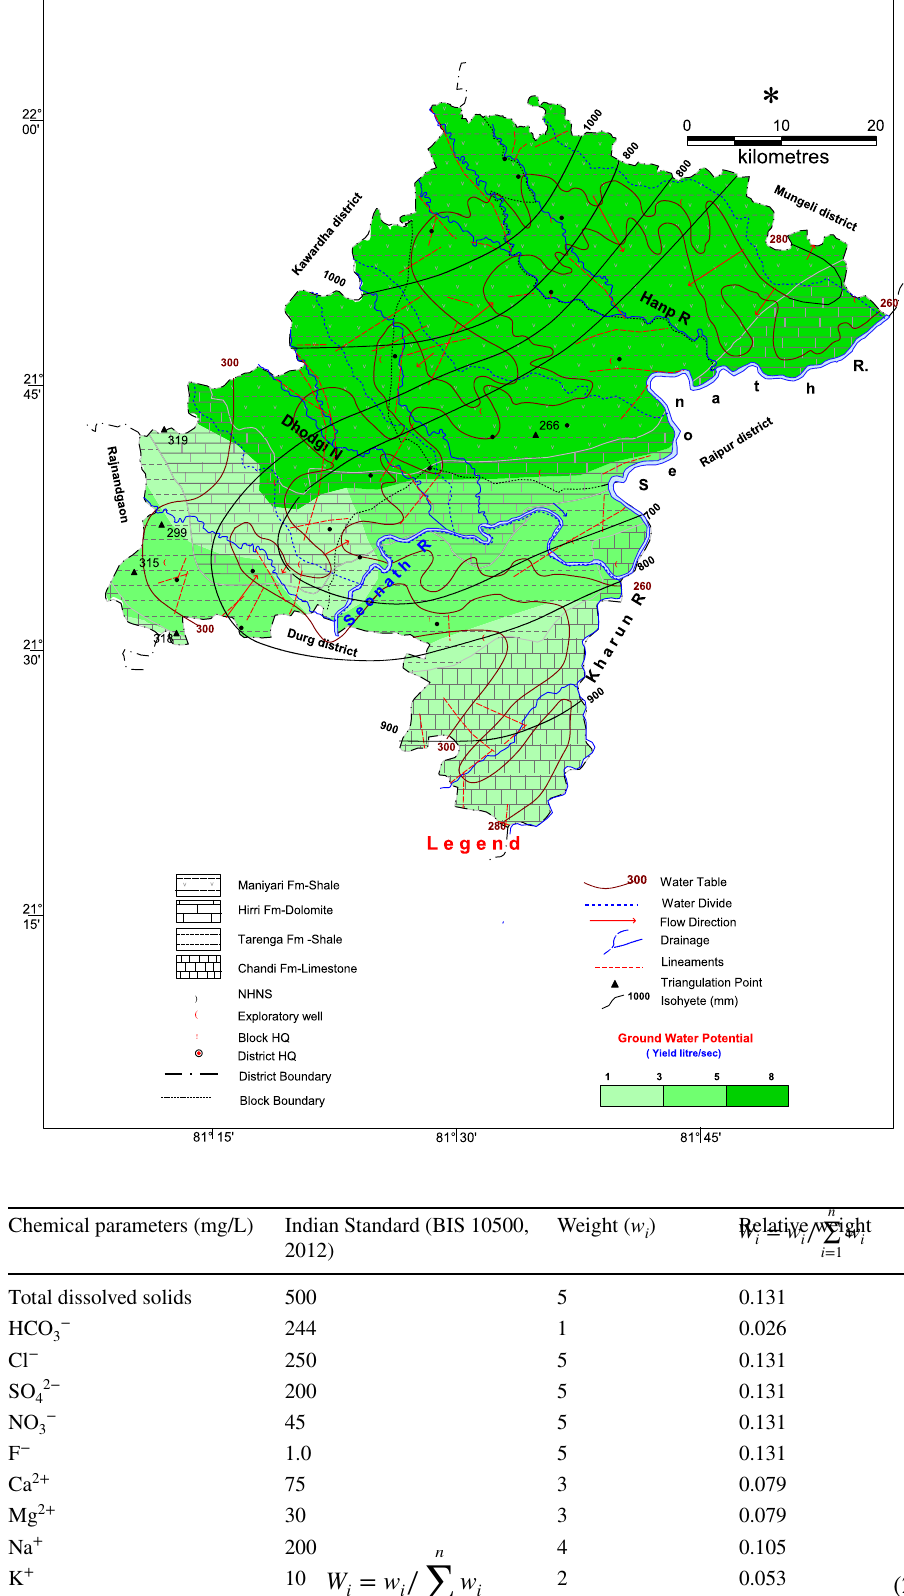
Fig. 3 Hydrogeology map of the study area